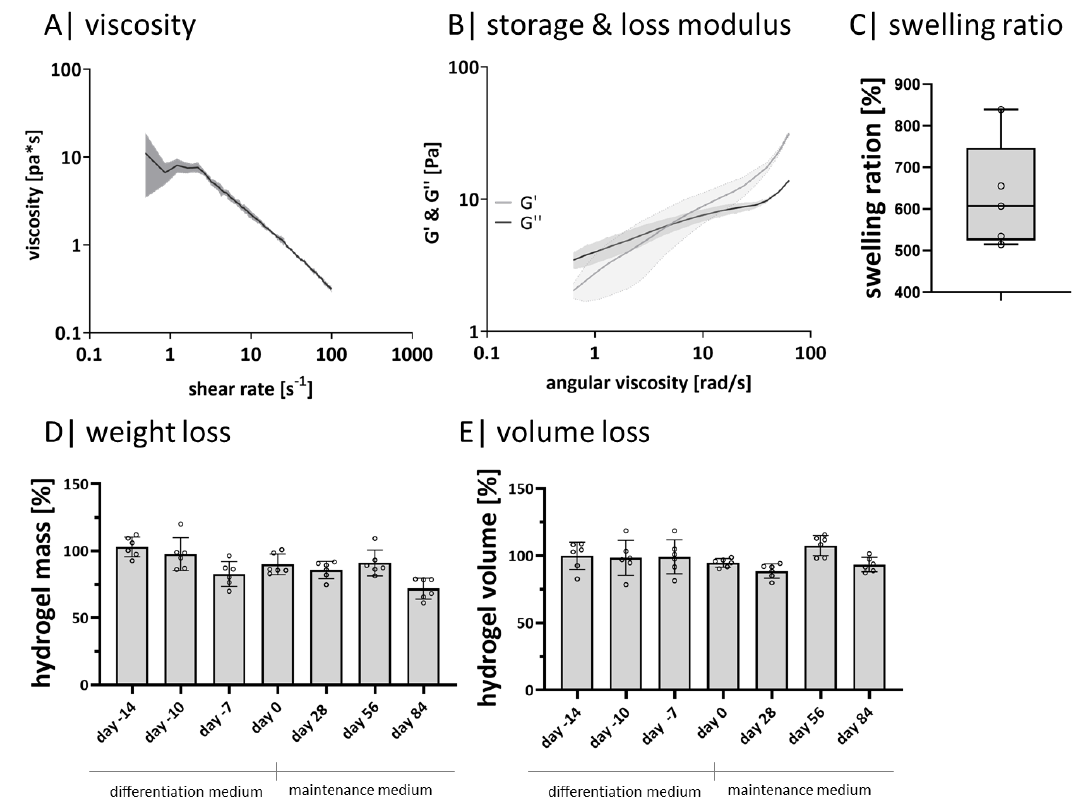
Figure 1. Hydrogel characteristics: ( A ) rheological measurement of the viscosity and ( B ) of the storage and loss modulus with a rotational viscometer, n = 3; ( C ) calculated swelling ratio of acellular, crosslinked hydrogels after 24 h, n = 6; ( D ) measured weight maintenance of crosslinked acellular hydrogels over 98 days, n = 6; ( E ) determined normalized volume change of crosslinked acellular hydrogels over 98 days, n = 6. ◦ sample values .